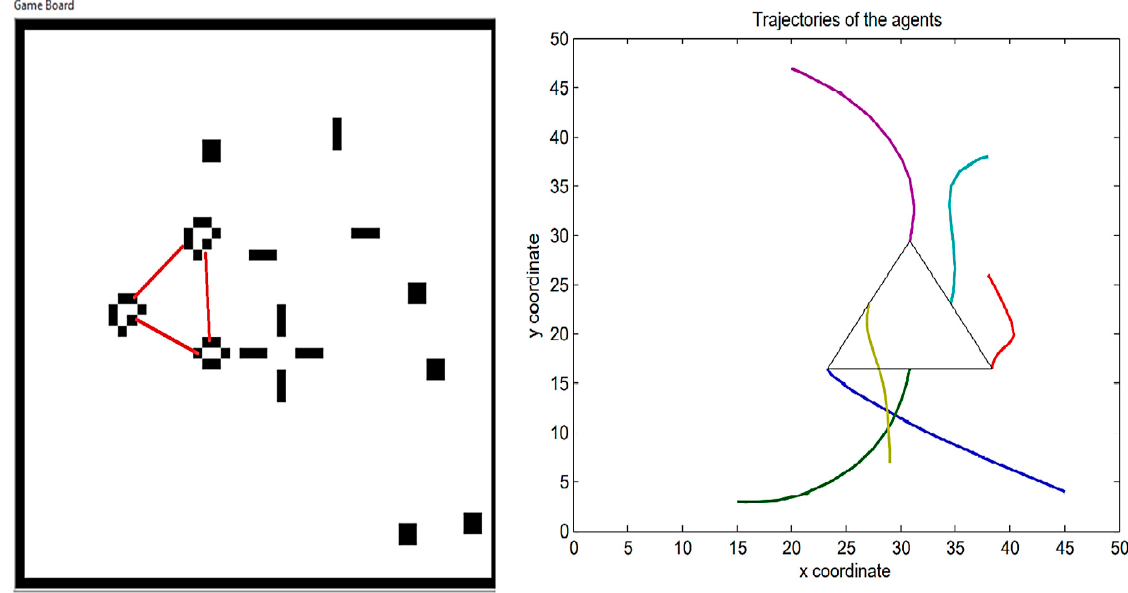
Figure 5. Trajectories of the agents with distributed formation control.